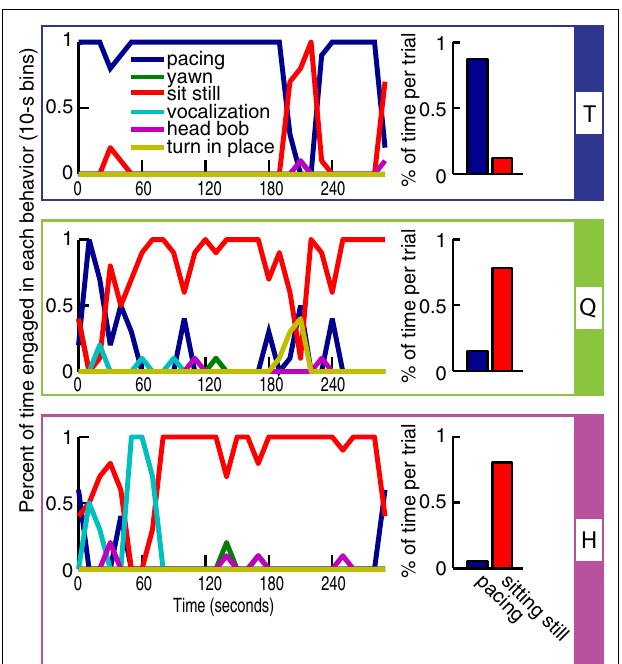
Individual differences in the number of fi xations The number of fi xations were signifi cantly different